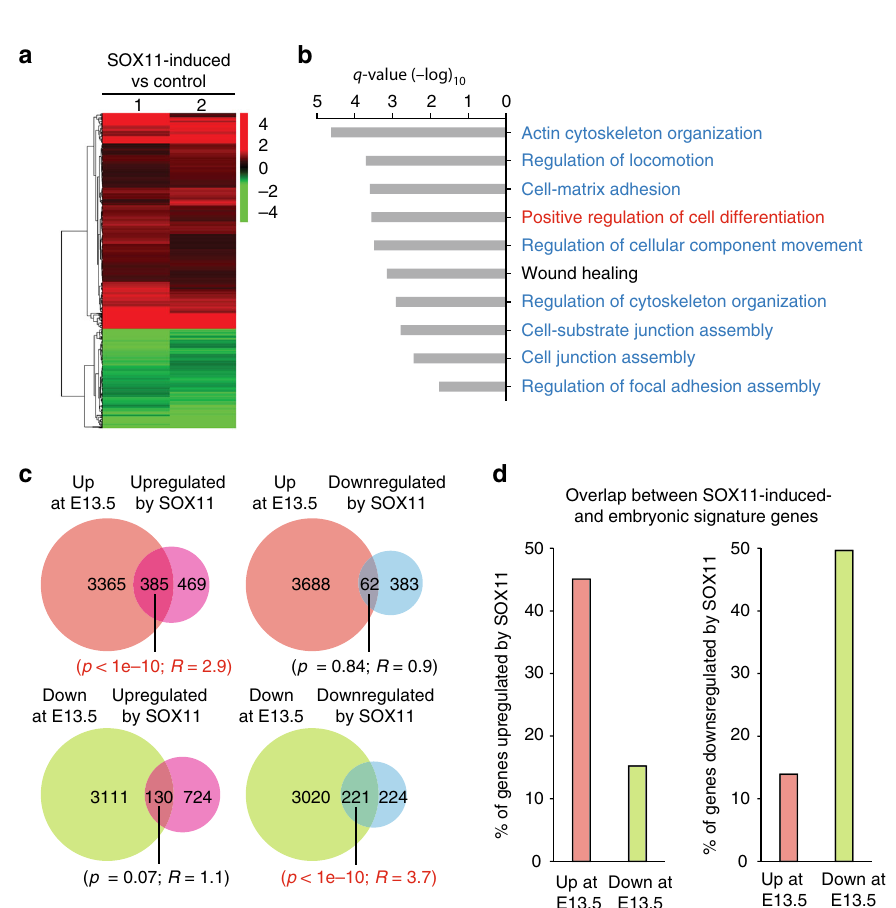
Fig. 3 SOX11 overexpression induces embryonic transcriptional program. a Heat map from two-color microarray analysis depicts clustering of differentially expressed (FDR < 0.05 and fold change> 1.5) probesets in K14-rtTA;TRE-Sox11 epidermis relative to control K14-rt TA epidermis at P4 after 12 h of Dox induction. Data from two biological replicates of each genotype. b Top ten GO biological processes of the differentially expressed genes in SOX11-induced epidermis. Cell organization and movement related (blue) and epidermal differentiation (red) processes are among the most signi fi cantly enriched. c High overlap of SOX11-induced signature genes and embryonic epidermal signature genes. The Venn diagrams show overlapping between E13.5 epidermal signature genes and genes changed by SOX11-induction (genes with log2-fold change > 1.5 in both microarrays). Venn diagram hypergeometric p values and the enrichment level ( R ) of the overlaps are indicated below each Venn diagram, with statistically signi fi cant values highlighted in red. d Percentage of genes altered by SOX11 overexpression overlapping with embryonic signature genes. Source data for panels a , c and d are provided as a Source Data fi